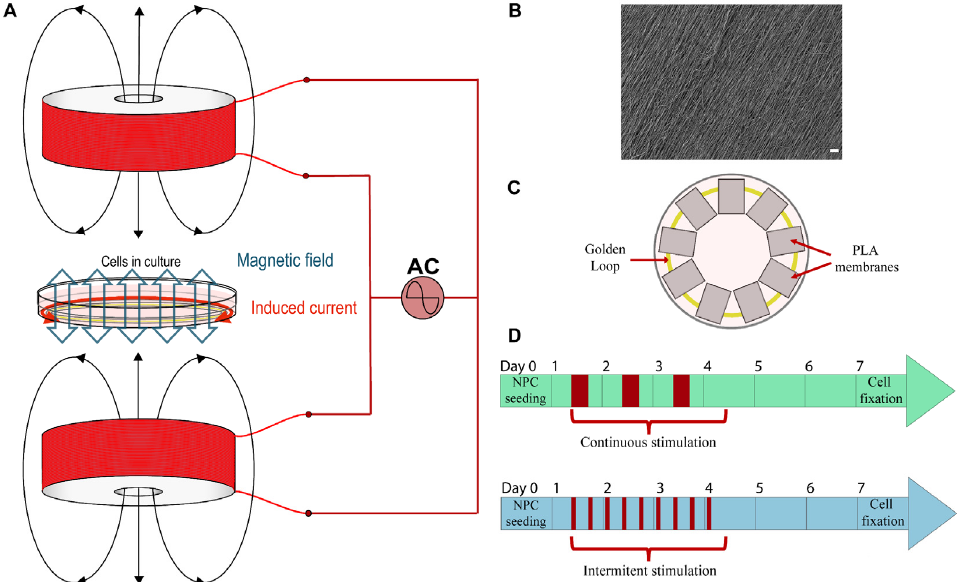
Figure 1. ( A ) Bioreactor arrangement scheme: an alternant sinusoidal current is injected into two coils to create an oscillating magnetic field that is directly applied to a culture dish, inside which a golden loop is placed, resulting in the generation of an induced current in this loop. ( B ) A representative scanning electron microscope image of an aligned PLA electrospun scaffold. Scale bar: 20 µm. ( C ) Scheme of the 35 mm culture dish assembly: the sterile golden loop is firstly placed inside the dish, and, after that, the PLA membranes, where the NPCs will be seeded, are positioned equidistantly from the culture dish center and over the golden loop. ( D ) Scheme showing the combined magnetic and electric stimulation protocol employed for continuous and intermittent stimulation pattern (in red is shown the stimulus application). Stimulation parameters in both continuous and intermittent stimulation were a frequency of 75 Hz, a magnetic field of 1.13 mT, and an induced current in the loop of 750 µA, applied for 3 days.